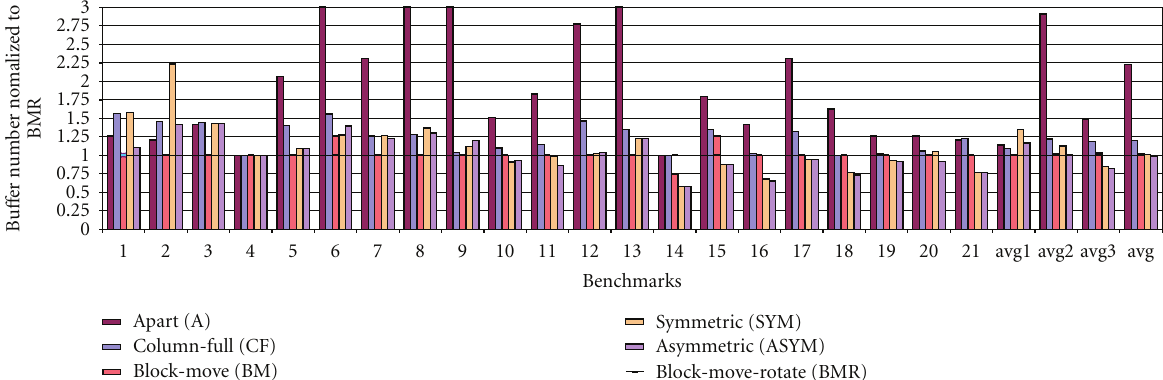
Figure 15: Bu ff er comparison between di ff erent techniques of mesh- and tree-based architectures.